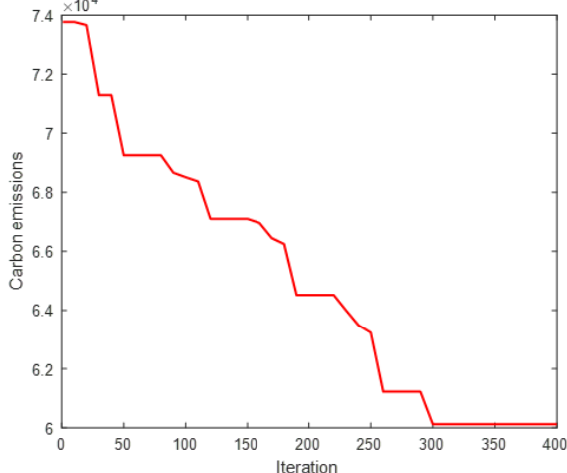
Figure 22. FAGA algorithm carbon emissions target iteration curve